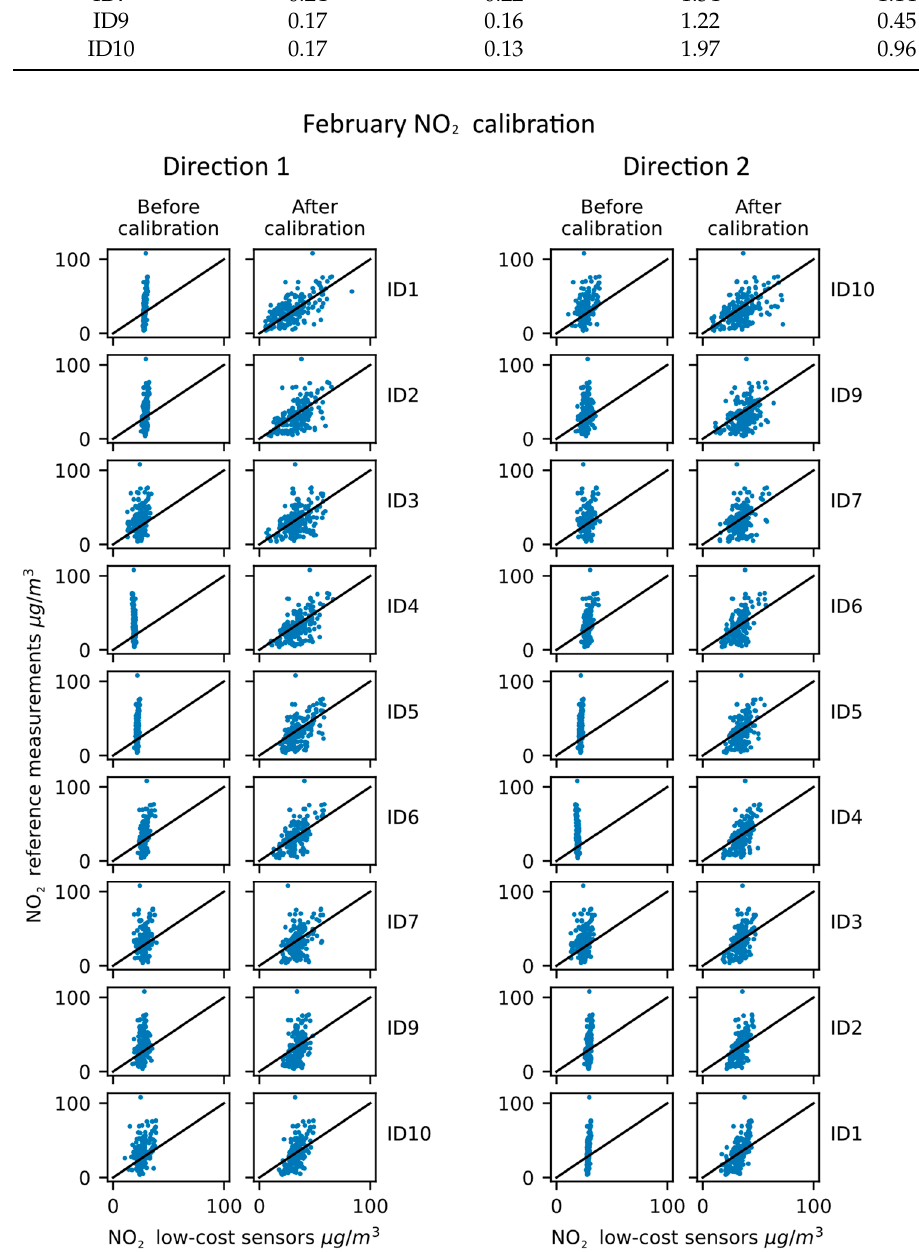
Figure 5. NO 2 calibration propagation—February results. Table 3. Results of the PM 10 calibration propagation in February, improvements in comparison to the parameters before calibration.